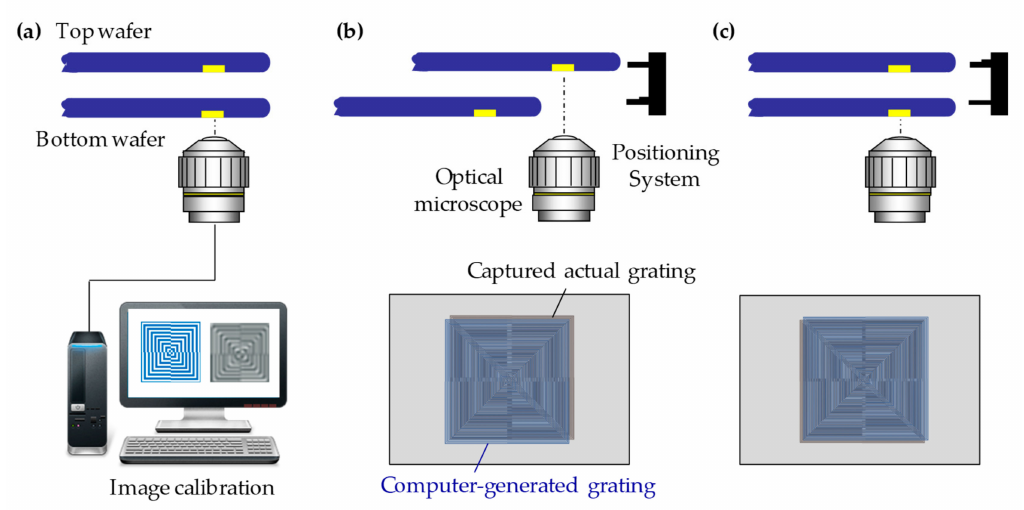
Figure 10. The working principle of moir é -based alignment for the backside alignment system: ( a ) the calibration between the computer-generated and the captured actual images; ( b ) detecting the top grating mark positions; ( c ) detecting the bottom grating mark positions and aligning two wafers by restoring the top and bottom mark